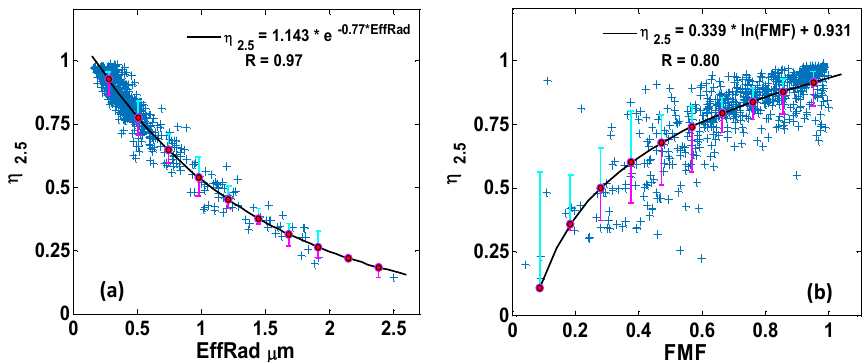
Figure 4. Simulation of η 2.5 (extinction fraction caused by particles with a diameter less than 2.5 μm) by